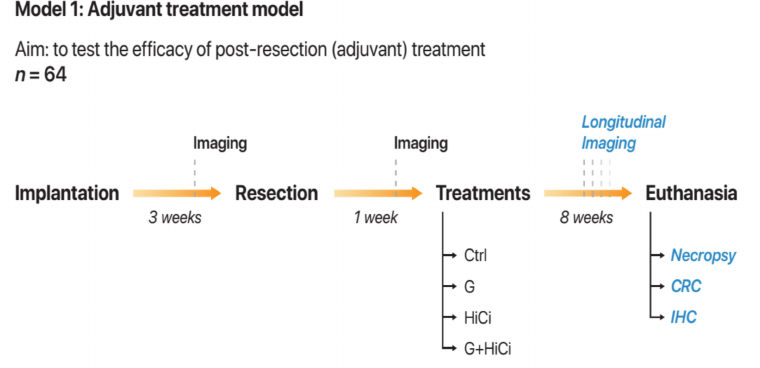
Figure A1. Flow diagram summarising the adjuvant treatment mouse model (Model 1). The aim was to test the efficacy of HGF/c-Met inhibition therapy (HiCi, rilotumumab and com-pound A) with or without gemcitabine (G) as adjuvant treatments for PC. The drugs were given in a 2 × 2 factorial fashion. Bioluminescence imaging was performed both pre- and post-resection. The major outcome measures (highlighted in blue) included longitudinal measures of tumour burden (as assessed by in vivo bioluminescence imaging), recurrence at necropsy (both macroscopic and microscopic), circulating rare cell numbers and immuno-histochemical assessment of recurrent tumours. Abbreviations: CRC, circulating rare cells. IHC,